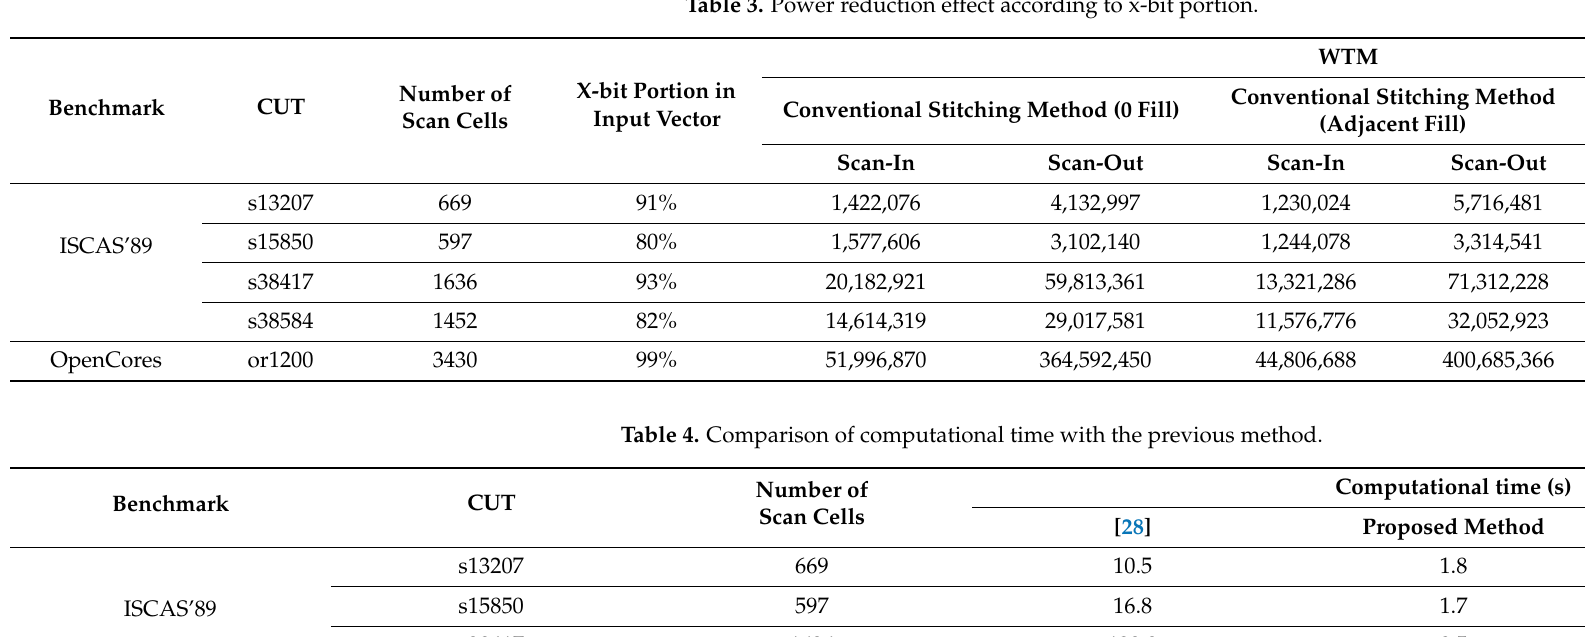
Table 3. Power reduction effect according to x-bit portion.